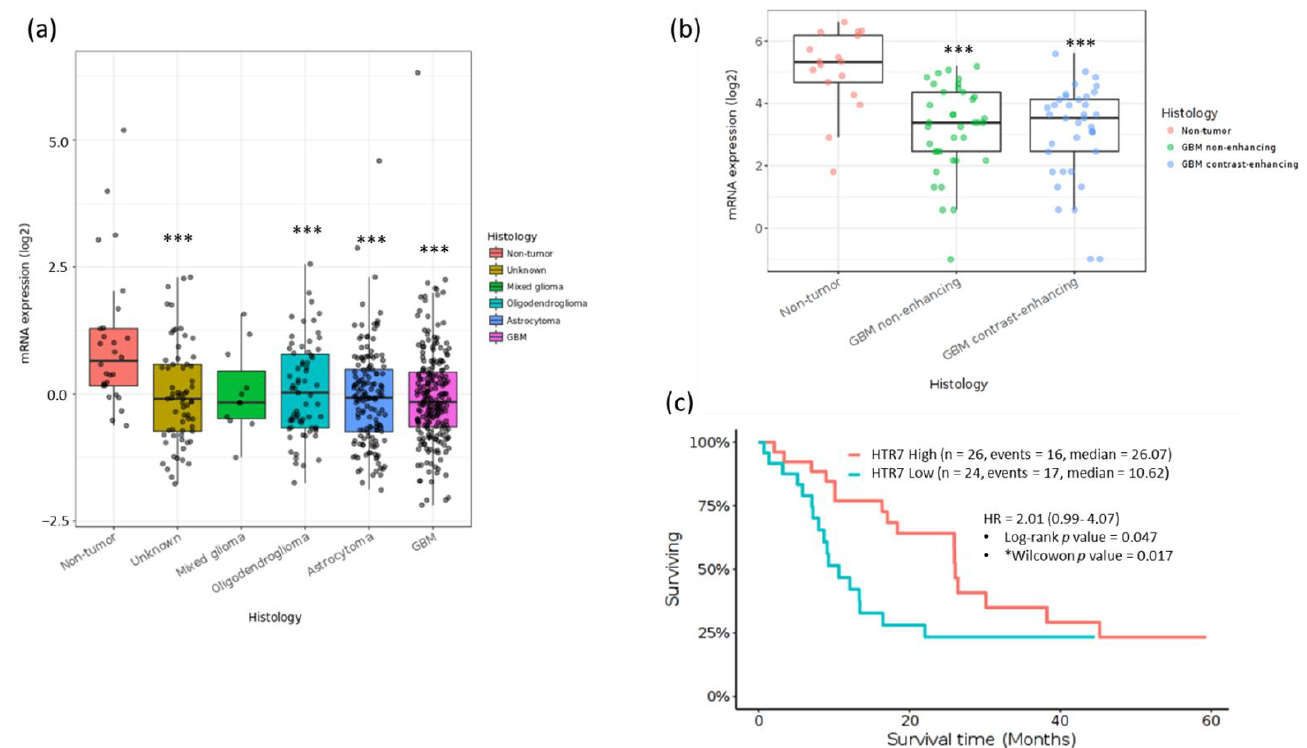
Figure 1. 5-HT 7 R mRNA expression in human brain cancers. ( a ) 5-HT 7 R is lower expressed in many brain tumors including GBM compared with normal tissues, data from Rembrandt. ( b ) The mRNA expression of the 5-HT 7 R was lower in tumor tissues of GBM patients than in the corresponding normal tissues, data from Gill database) *** p < 0.001, Tukey’s Honest Significant Difference (HSD); ( c ) Kaplan–Meier estimator survival analysis from Nutt datasets. The split in two groups, HTR7 low and HTR7 high has been performed by the median. Data from TCGA, http://cancergenome.nih.gov, 13 March 2022. * p < 0.05.